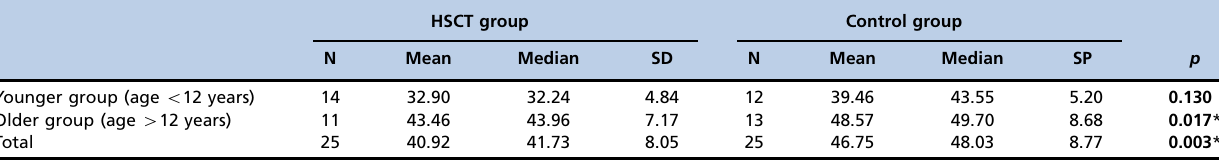
Table 2 - Mandibular ramus vertical extension (mm).